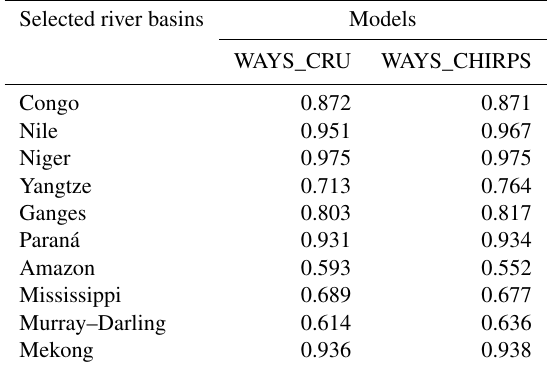
Table 3. The rank correlation of NDII and WAYS-simulated RZWS in 10 selected